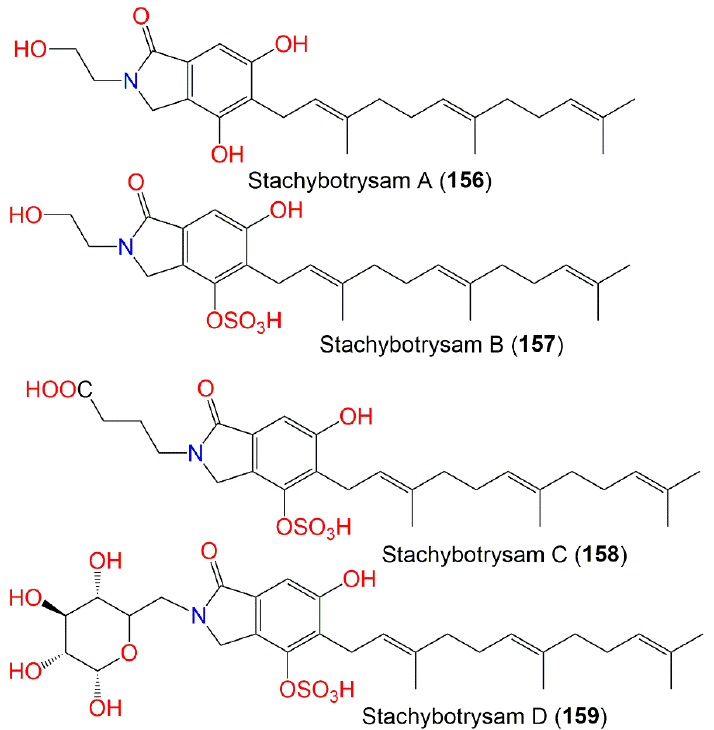
Figure 20. Structures of isoindoline derivatives ( 156 – 159 ) reported from S . chartarum .